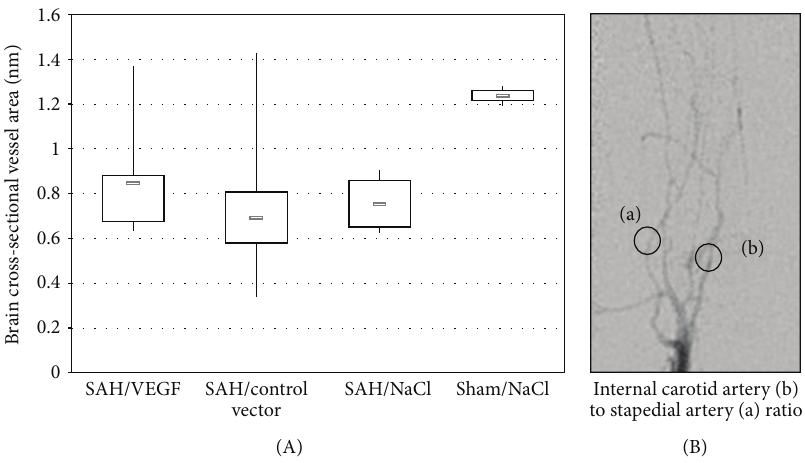
Figure 2: (A) The brain cross-sectional vessel area in mm in the three SAH groups and the sham group. Displayed are the lowest, highest, and median values of brain cross-sectional vessel area (in mm), with upper (75%) and lower (25%) quartiles. (B) Digital subtraction angiography of rat number 11 demonstrating the internal carotid artery (b) to stapedial artery (a) ratio.